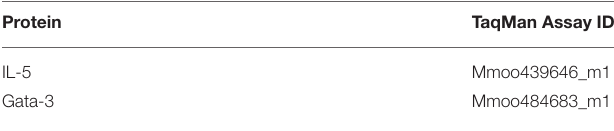
TABLE 1 | Primers used for qPCR experiments.